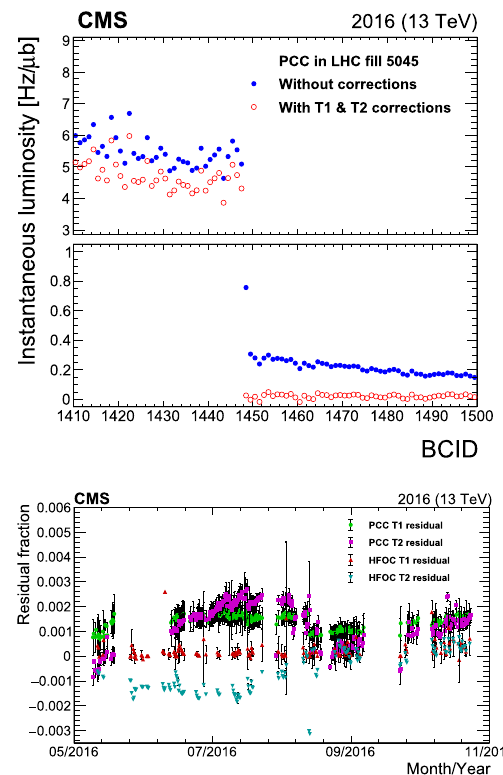
Fig. 15 The upper plot shows the instantaneous luminosity measured from PCC as a function of BCID before (filled blue points) and after (open red points) afterglow corrections are applied for each colliding bunch. The upper panel shows a subset of bunch crossings colliding at IP 5, and the lower panel shows empty bunch crossings (the scale is different in the two panels to show differences more clearly). The open red points in the lower panel lie close to 0, indicating that any residual PCC response is small in empty bunch slots. The lower plot shows the estimated residual T1 and T2 afterglow as a function of time during the full range of 2016 data for both PCC and HFOC, which use the same afterglow subtraction